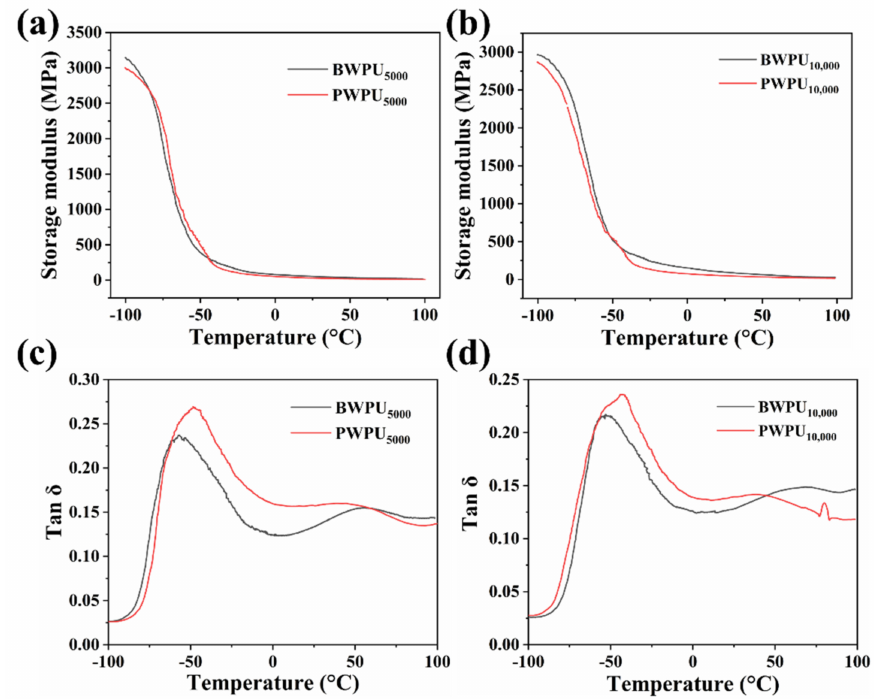
Figure 8. ( a ) Storage modulus versus temperature in BWPU 5000 and PWPU 5000 ; ( b ) Storage modulus versus temperature in BWPU 10,000 and PWPU 10,000 ; ( c ) Tan δ versus temperature in BWPU 5000 and PWPU 5000 ; ( d ) Tan δ versus temperature in BWPU 10,000 and PWPU 10,000